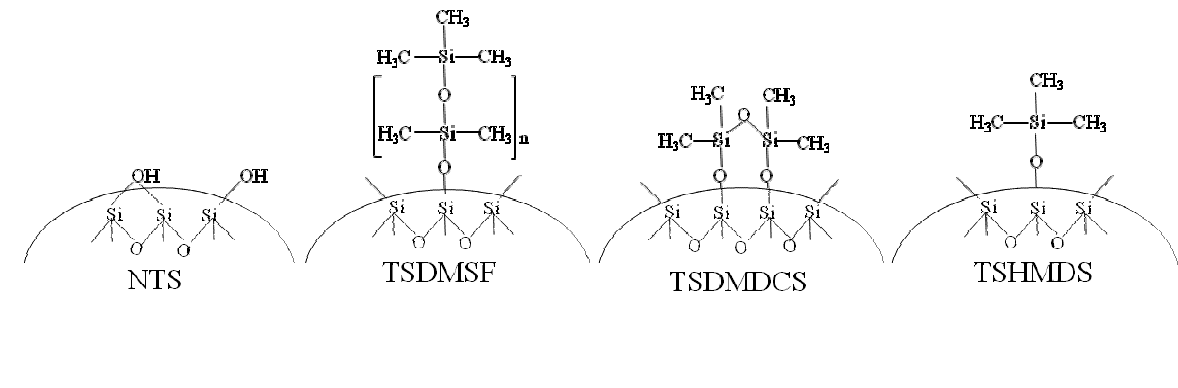
Figure 1. Different organo-silicon groups on the surface of variously treated fumed